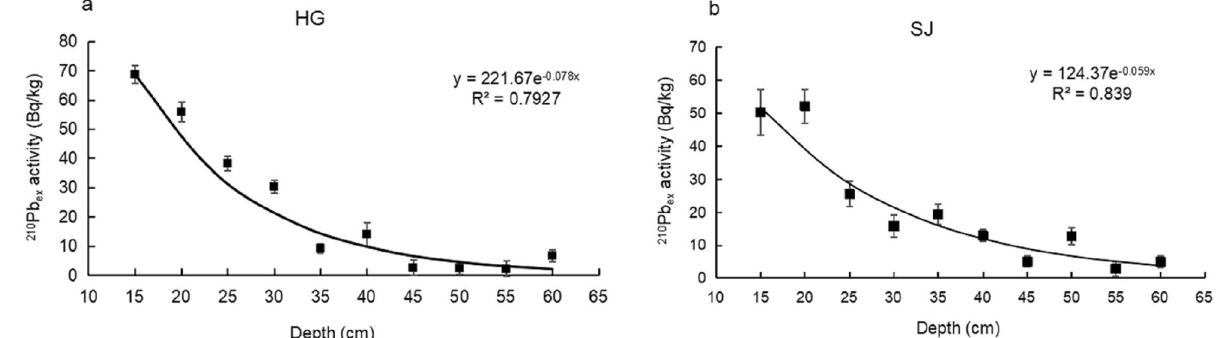
Figure 4. 210 Pb ex activity profiles in selected cores such as from ( a ) station HG and ( b ) station SJ.